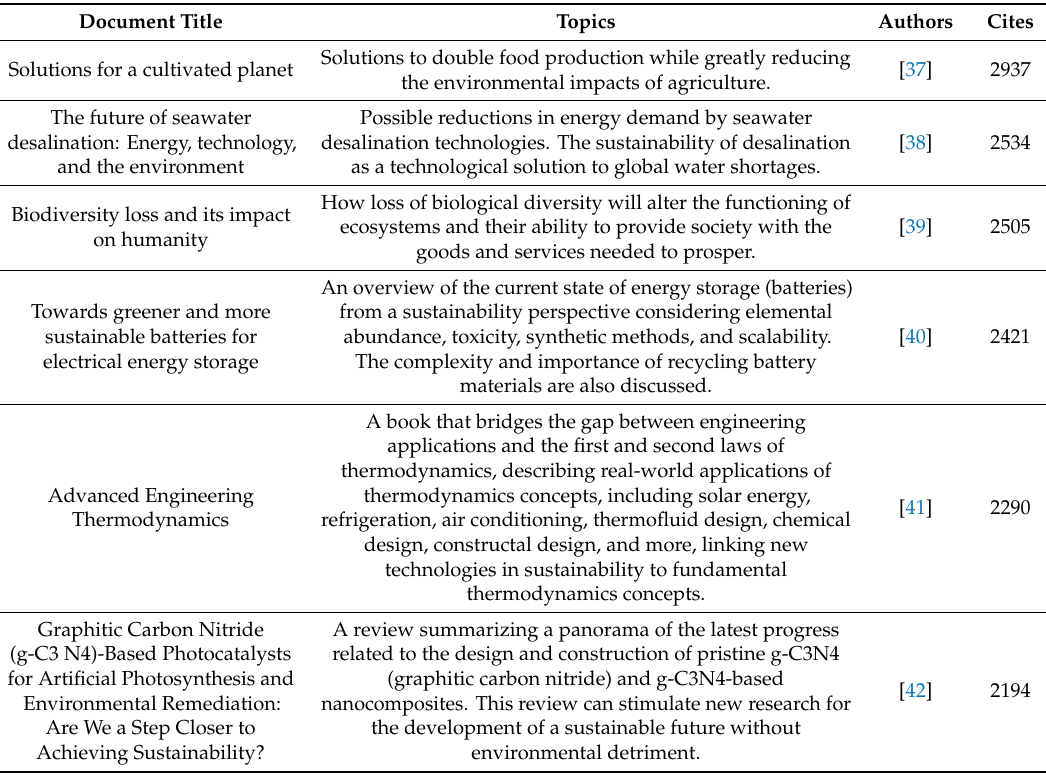
Table 4. Most cited documents between 2011 and 2020.